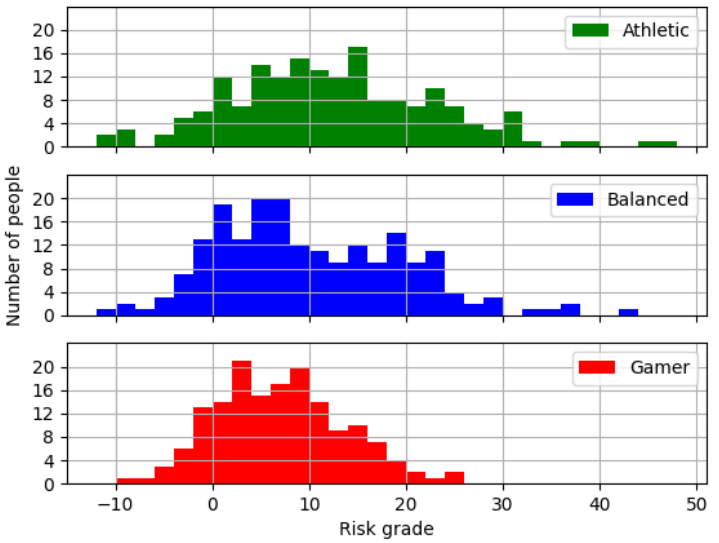
Figure 9. Histograms of risk grades for the three behavioral types. From athletic to gamer, the bulk of the grades move towards smaller values.